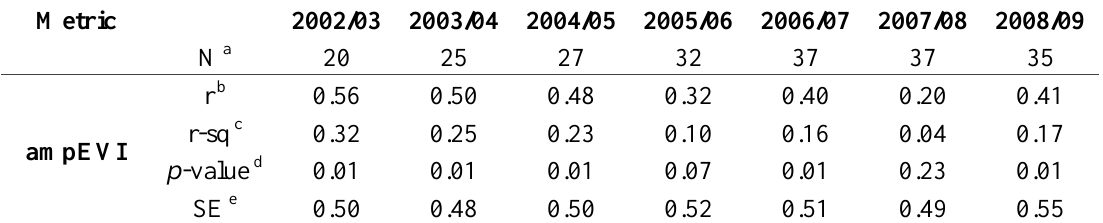
Table 2. Correlation coefficients between variation on coffee yield and variation on EVI metrics in the same year for each metric